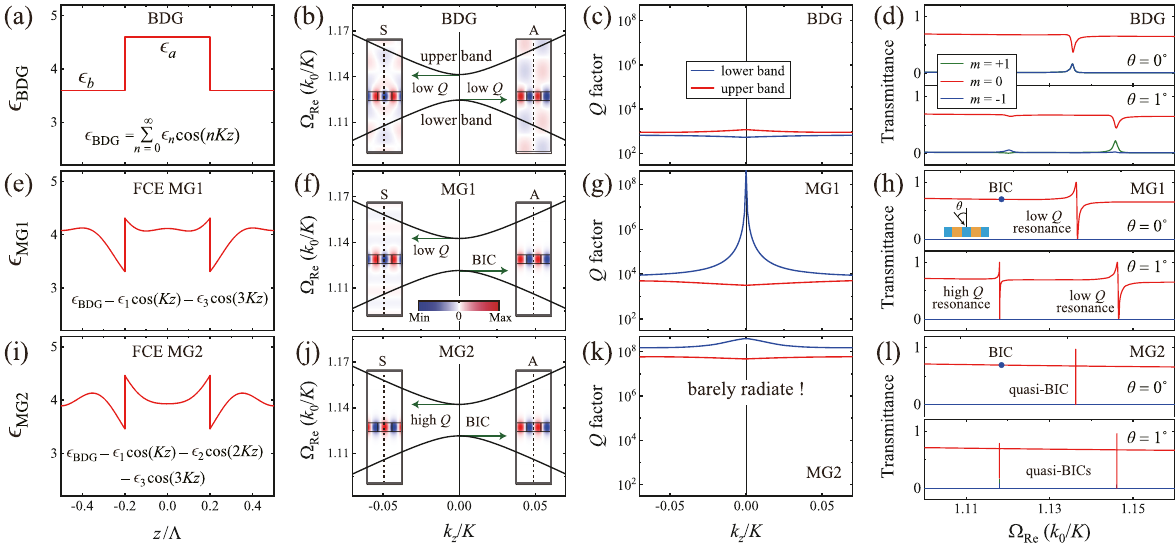
Figure 3: Comparisons between the key properties of the conventional (a)–(d) BDG, (e)–(h) FCE MS1, and (i)–(l) FCE MS2. (a), (c), and (i) depict the dielectric functions with respect to z . (b), (f), and (j) show the FEM-simulated dispersion relations. The blue and red insets ) distributions of the band edge modes on the y = 0 plane. The vertical dotted lines represent the mirror illustrate the spatial electric field ( E y planes in the computational cells. (c), (g), and (k) show the calculated radiative Q factors of the lower and upper bands. (d), (h), and (l) show the transmission spectra through the BDG, FCE MS1, and FCE MS2. In the FEM simulations, the following structural parameters were used: 𝜖 = 4 . 00, Δ 𝜖 = 1 . 00, 𝜖 = 1 . 00, t = 0 . 30 Λ , and 𝜌 = 0 . av s